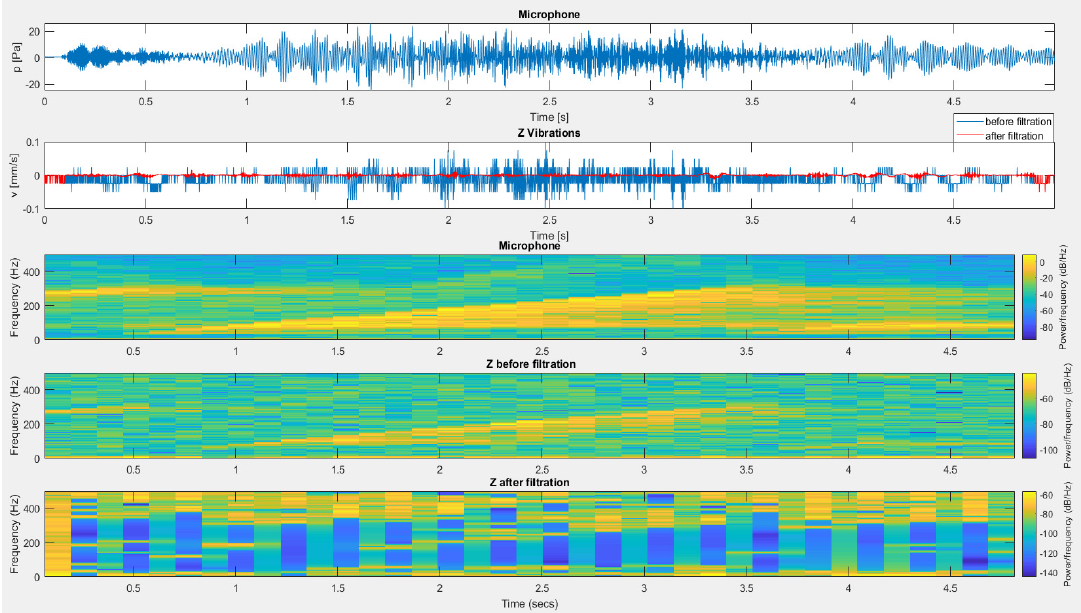
Figure 14. The result of using filtration for the data from the recording shown in Figure 6 (test No. I) for the vertical component of a suspended sensor on the structure.